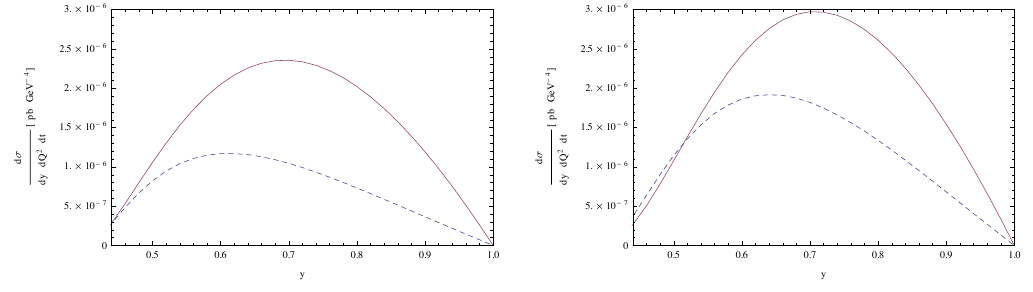
Figure 1: The y dependence of the longitudinal contribution to the cross section d σ ( ν N → l − ND + ) = 0 and s = 20 GeV 2 for a proton (in pb GeV − 4 ) for Q 2 = 1 GeV 2 , ∆ T d y dQ 2 dt (left panel) and neutron (right panel) target : total (quark and gluon, solid curve) and quark only (dashed curve)